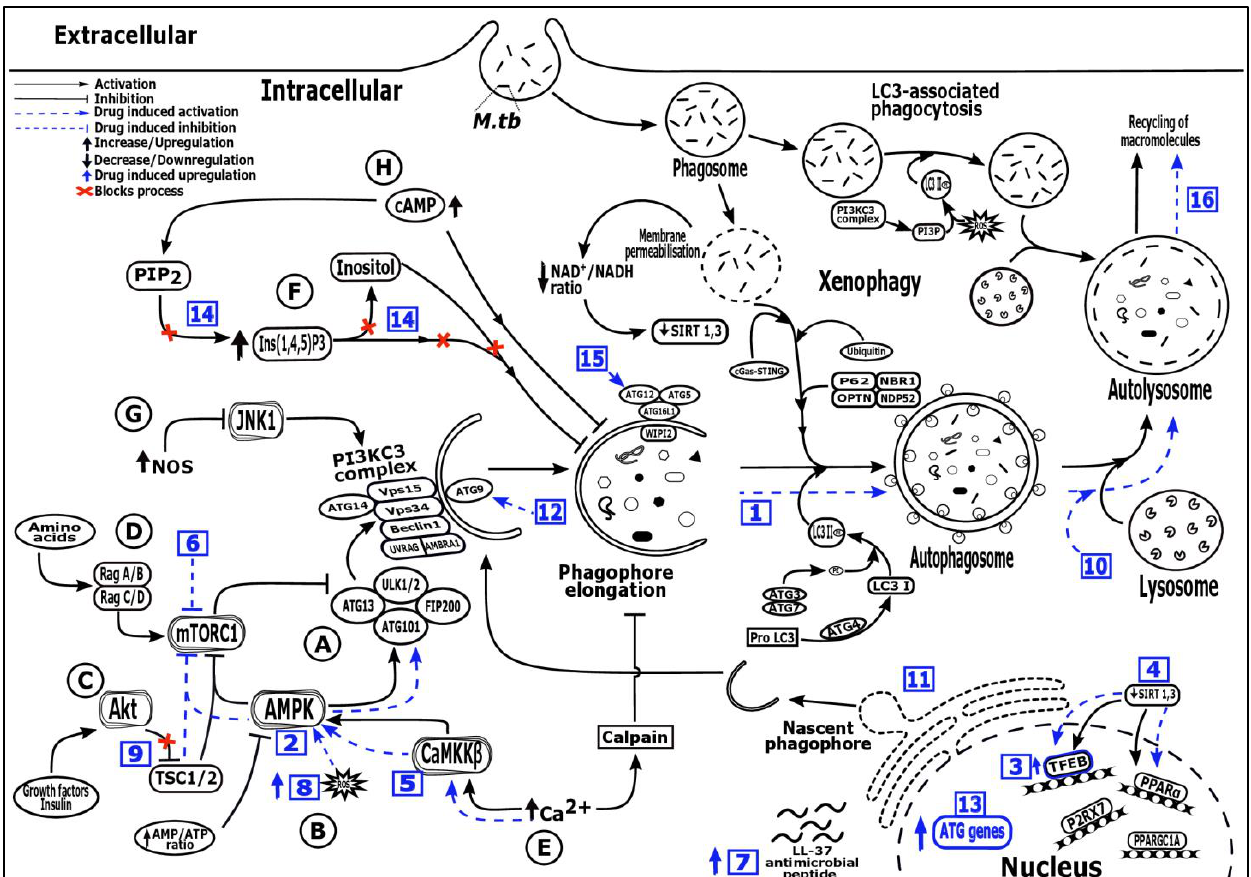
Figure 1. Regulatory mechanism of autophagy pathway and potential targets ofdifferent host directed therapeutic drugs.